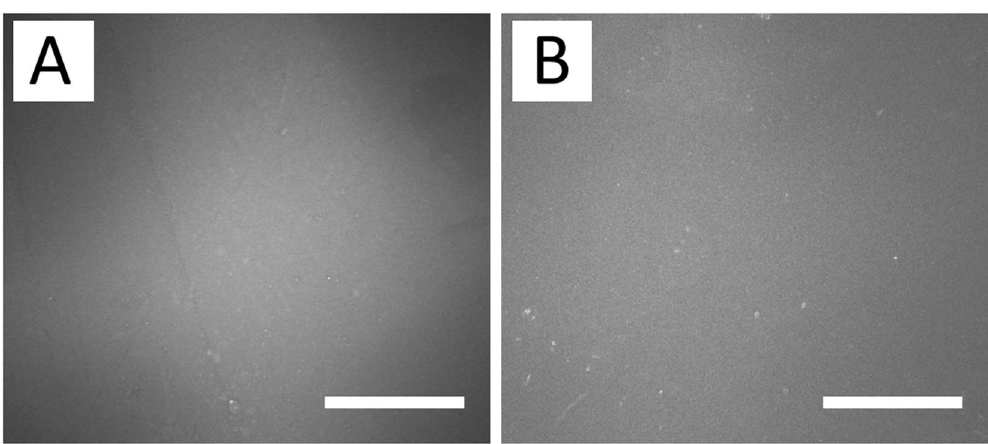
Figure 6. SEM photo of the stent surface, ( A ) before elution, and ( B ) 16 weeks after the elution process (n = 5) (scale bar = 50 μ